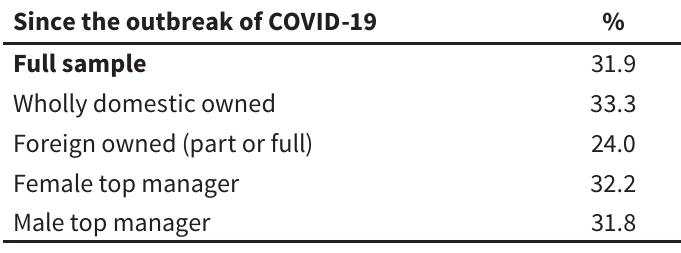
Proportion of firms applying for a